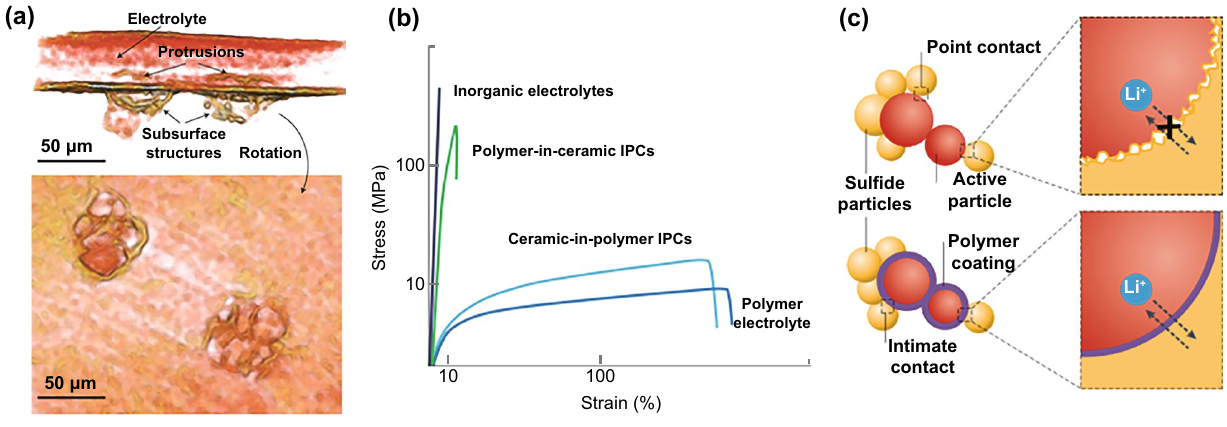
Fig. 4 a 3D reconstructed volumes of the dendrite located on the subsurface below the polymer/electrode interface [54]. Copyright 2014, Springer Nature. b Stress–strain curves of different SSEs [23]. Copyright 2021, Springer Nature. c PIEs can improve the contact stability with electrode [23]. Copyright 2021, Springer